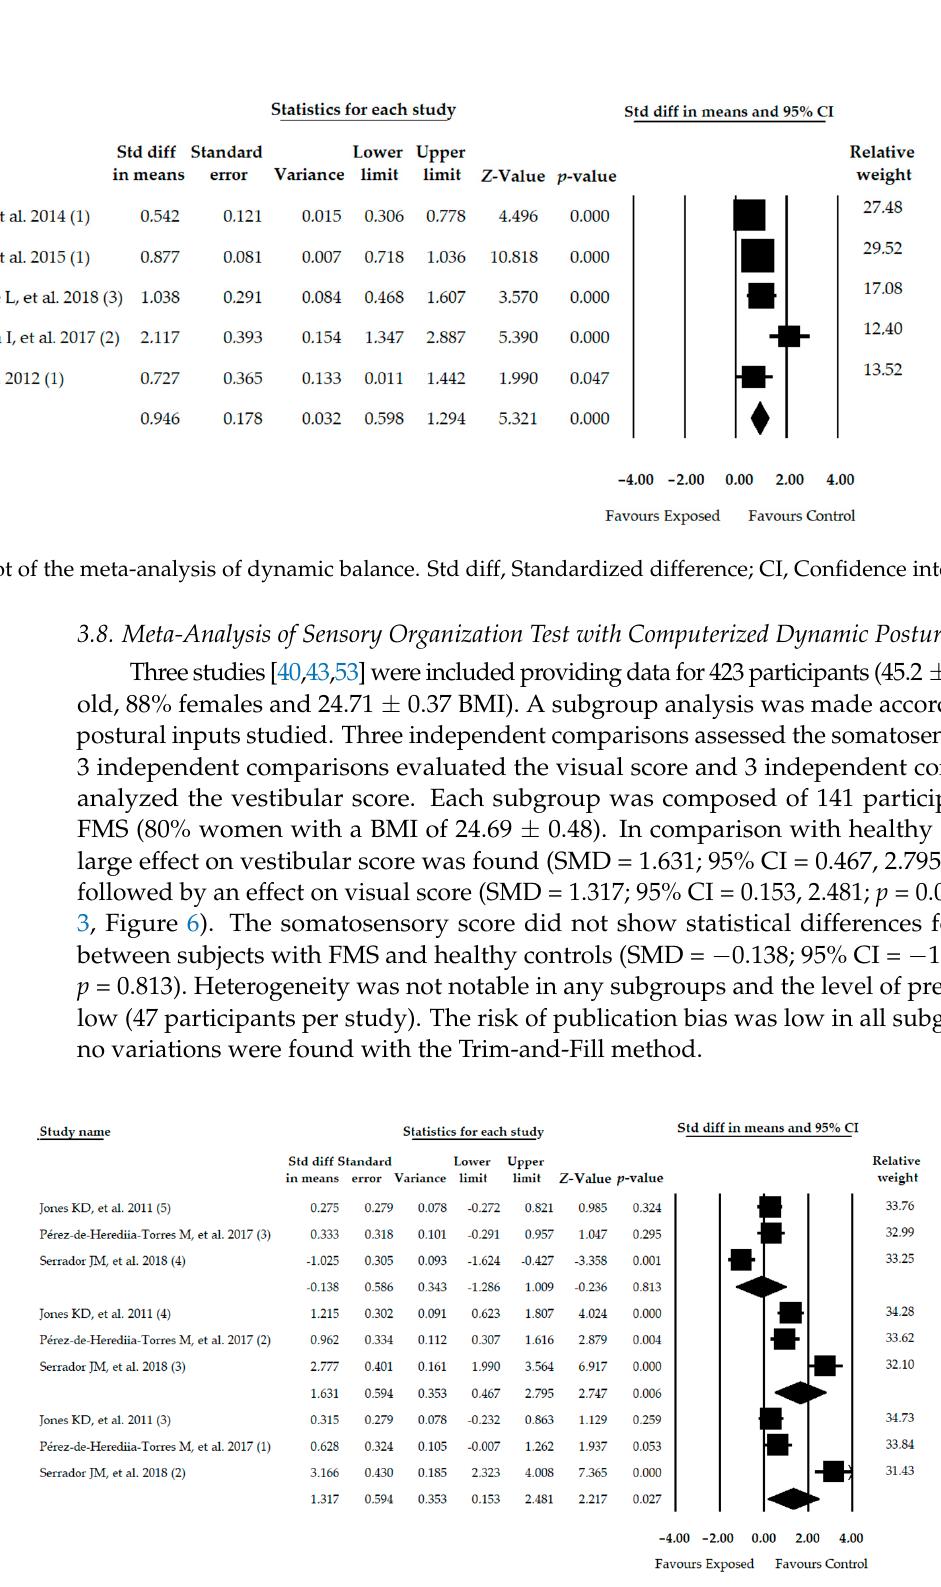
Figure 6. Forest plot of the meta-analysis of Sensory Organization Test. Std diff, Standardized dif- ference; CI, Confidence interval.